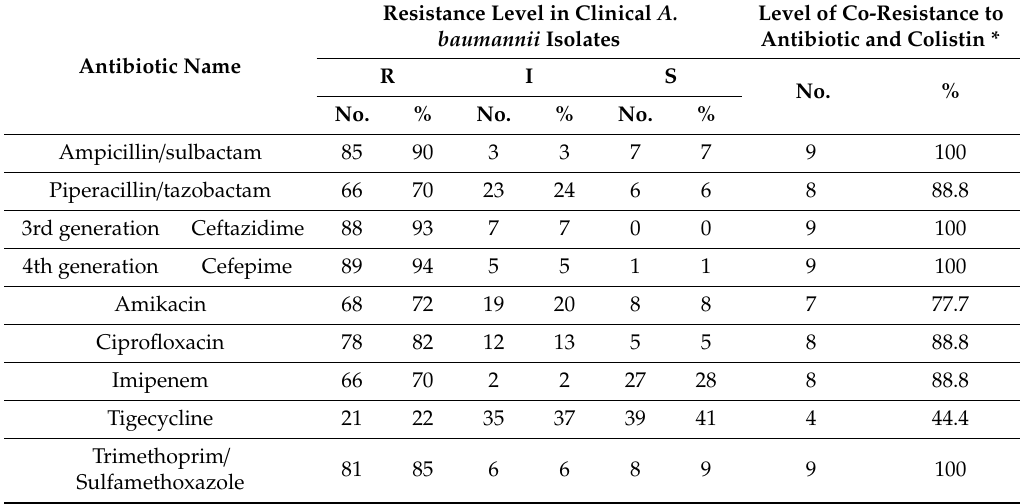
Table 1. Sensitivity index of Acinetobacter baumannii clinical isolates and co-resistance to antibiotics and